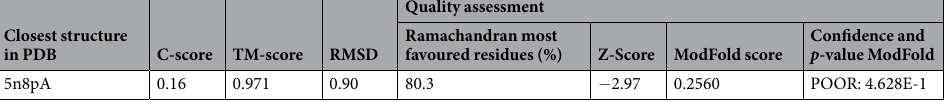
Table 3. Protein structurally close to the model in the PDB and Quality assessment of the model. C-score of model indicates the global topology, higher score means the better model ( >− 1.5 considered as a good topology). TM-score meas0075res the significance of the structural alignment between modelled protein and validated structures in PDB. RMSD: the root mean square deviation (RMSD) between residues that are structurally aligned.